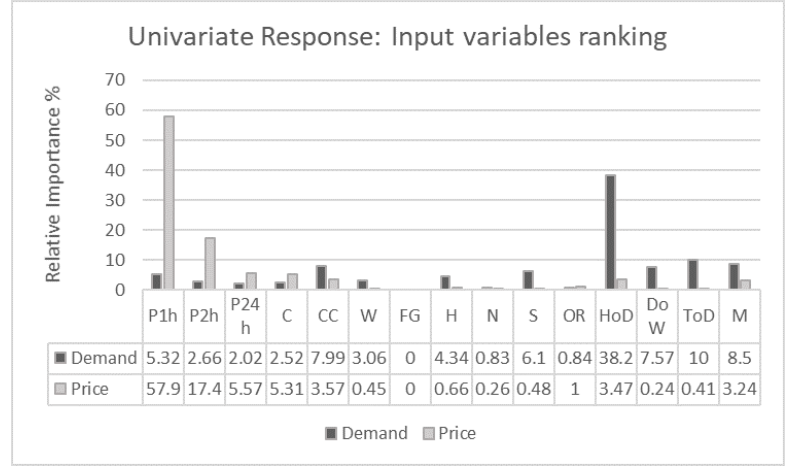
Figure 16. Univariate response variable importance analysis: relative importance in % of the predictors to each independent response, demand and price of electricity.